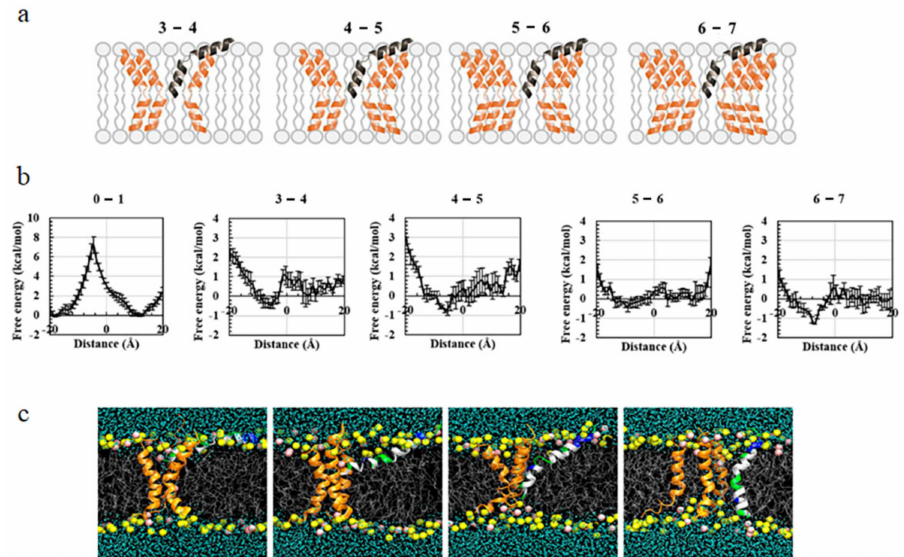
Figure 6. PMF distribution during insertion of melittin into a membrane with embedded peptides. ( a ) Sketches showing the insertion of a peptide (black) into a pre-existing pore of di ff erent sizes; ( b ) PMF profiles under various situations; ( c ) snapshots showing the translocation of a single peptide into a pore consisting of a three-peptide aggregate. From left to right, the peptide inserting position is: 11.99 Å, 4.49 Å, − 6.21 Å, and − 15.34 Å. The figure is adapted with permission from [91], copyright 2017, AIP